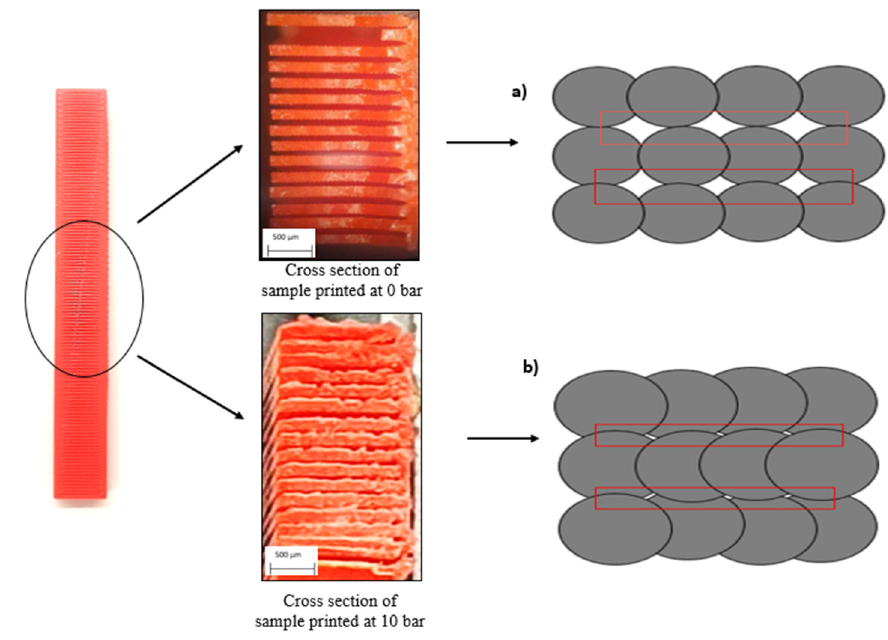
Figure 9. The cross-sectional view of 3D printed fractured specimen of FDM 3D-printing under ( a ) vacuum conditions and ( b ) in ambient additional pressure highlighted with voids volume.